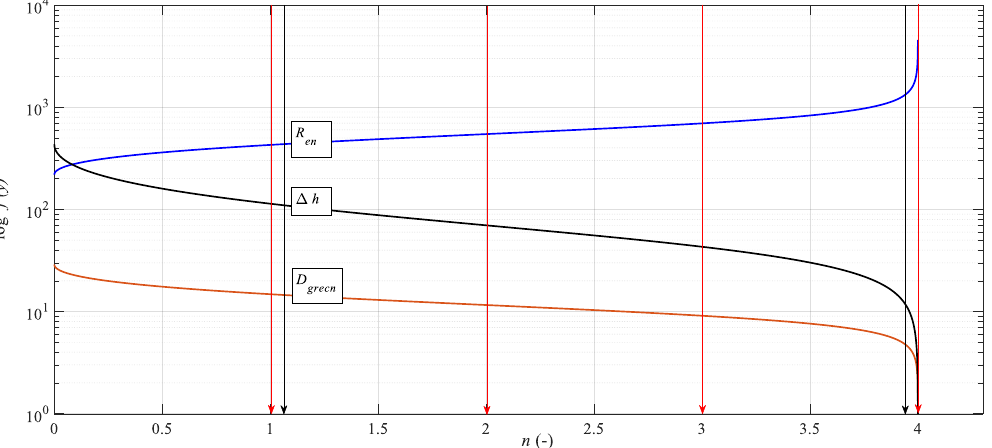
Figure 17. Dependence of grain reduction and other functions on the degree of extrusion.